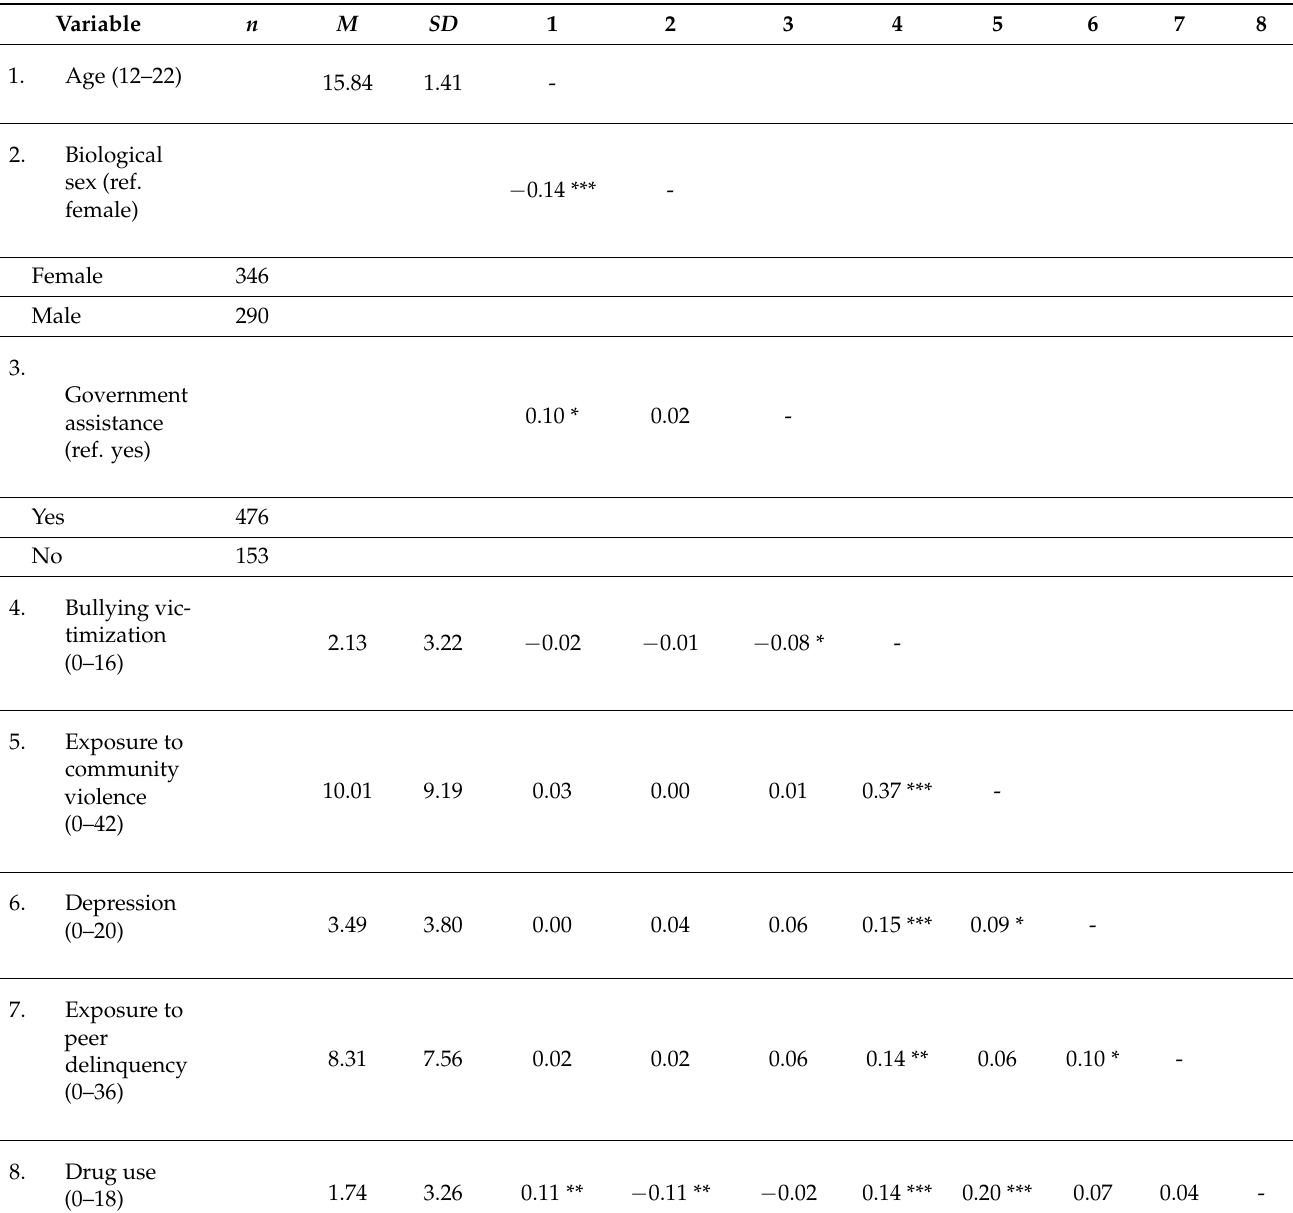
Table 1. Descriptive Statistics and Correlations among the Study